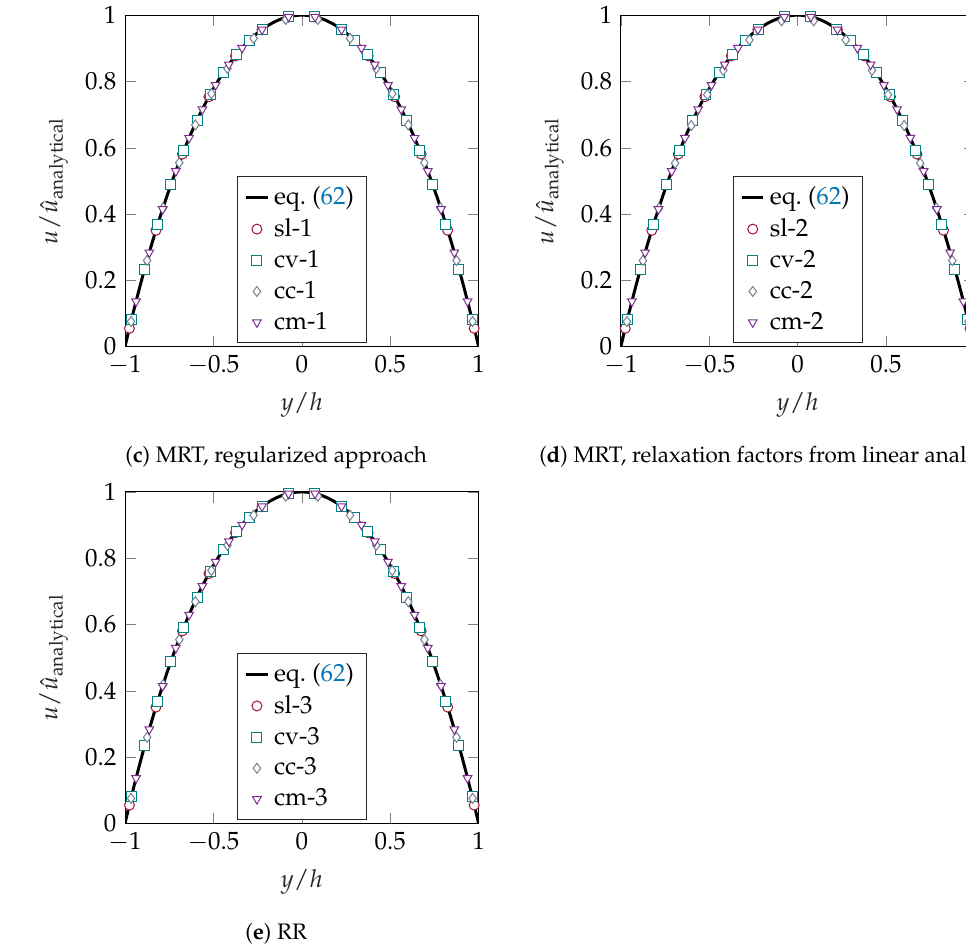
Figure A2. Normalized square duct velocity profiles for various tested models with ˜ ω c = 1.94990 (Re h , b =